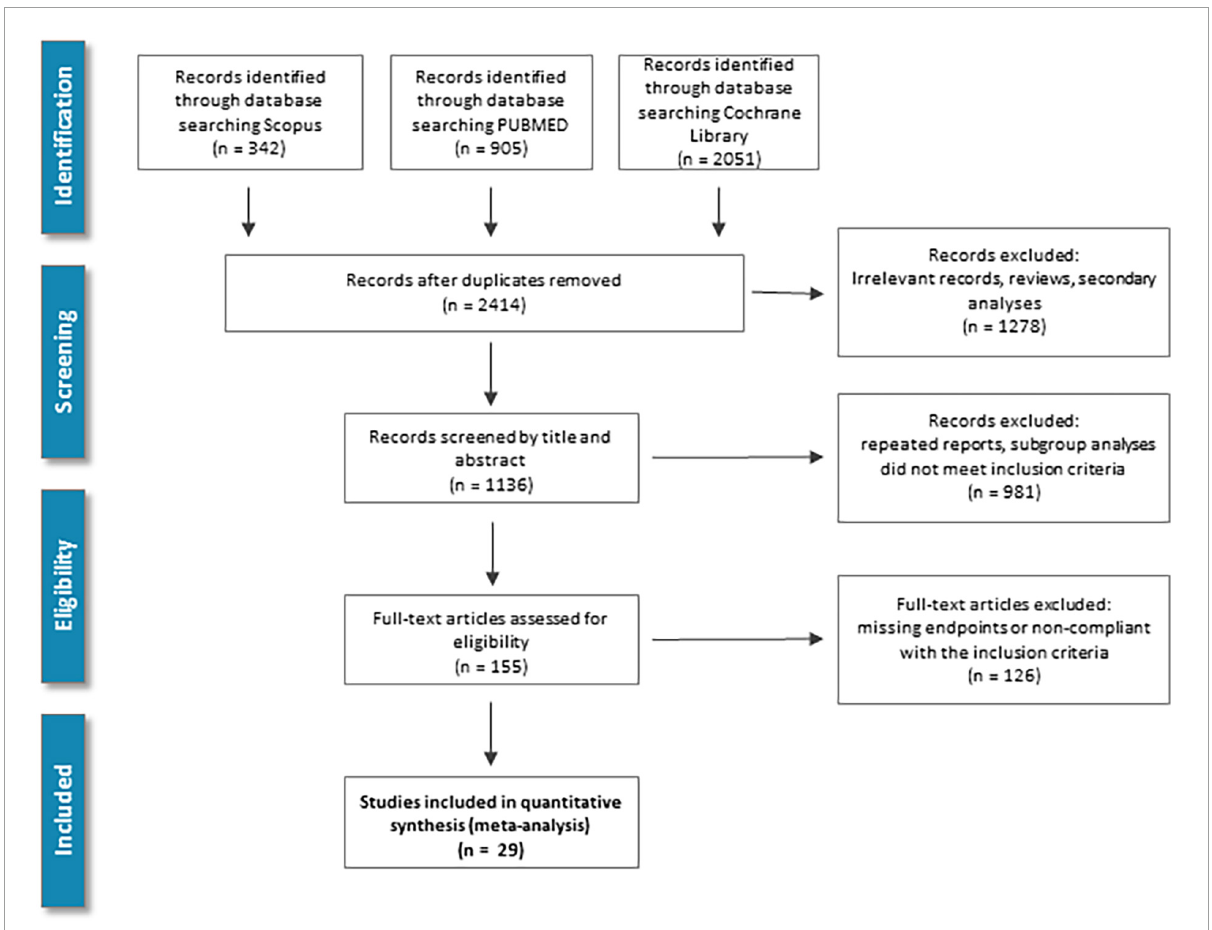
FIGURE1 Study screening and selection flow: Overview of study screening and selection process according to PRISMA